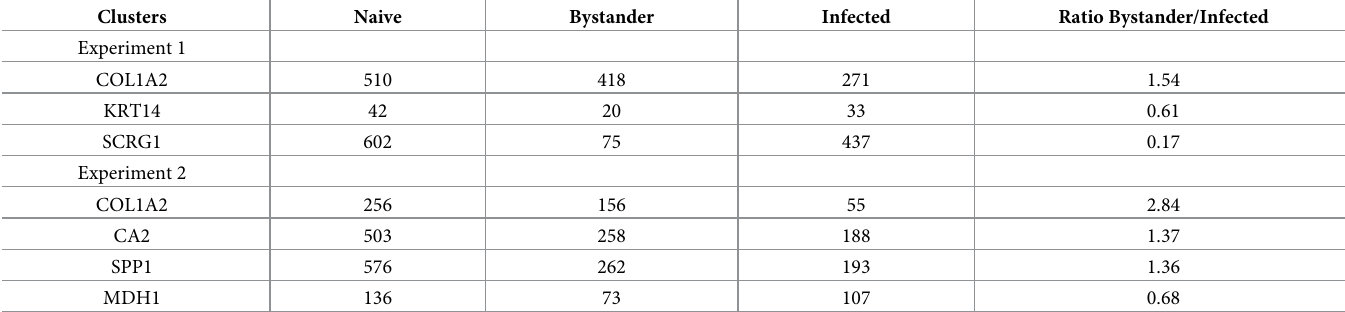
Table 1. Repartition of the numbers of na ï ve, bystander and infected cells in the different clusters. In both cases, the cluster defined as “COL1A2” contains the higher proportion of bystander cells. Clusters